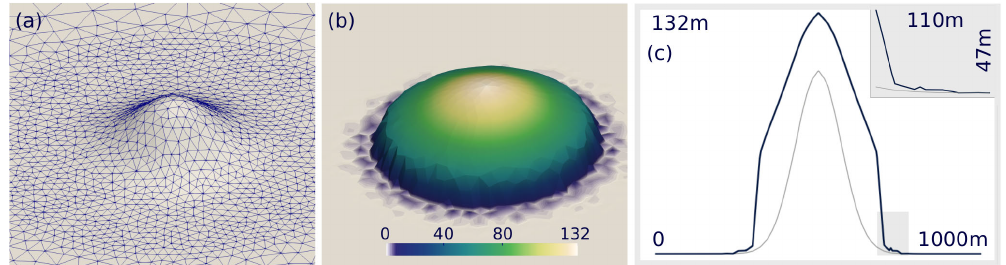
Figure 11. In (a) the ice-free geometry mesh formed by a Gaussian-shaped hill in flat terrain and in (b) the simulated surface elevation after 24 years (standard continuous Galerkin stabilised with SUPG) is shown with a cross-profile of surface (blue) and bed (grey) elevation in (c) .